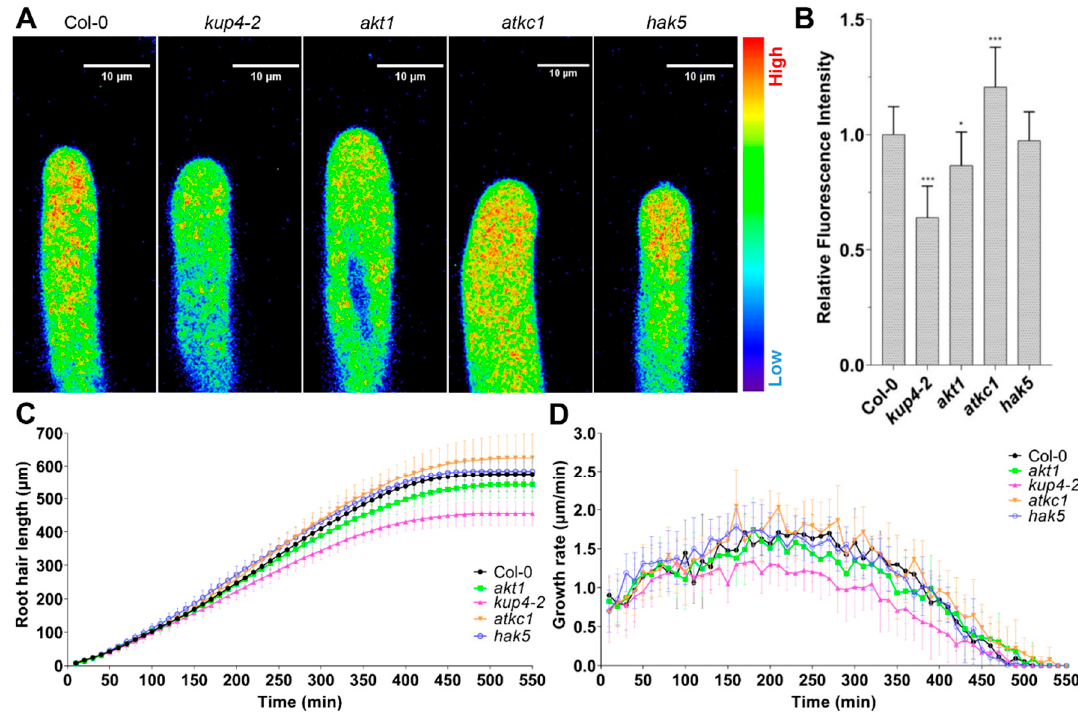
Figure 2. Mutants of K + transporters/channels show altered NK3 fluorescence intensity and root hair growth: ( A ) NK3 fluorescence intensity images of root hairs of Col-0, kup4-2 , akt1 , atkc1 , and hak5 immersed in ½ MS medium containing 1 μ M NK3 and visualized using pseudocolor; ( B ) Quantification of the fluorescence intensity in A. Bars represent the average intensity (mean ± s.d.) of fourteen hairs (Student’s t -test between Col-0 and mutant seedlings; * p < 0.05, *** p < 0.001); ( C ) Growth curve of root hairs of 5-day-old green seedling of Col-0, kup4-2 , akt1 , atkc1 , and hak5 transferred on ½ MS medium. Bars represent the average length (mean ± s.d.) of twelve hairs; ( D ) Growth rate curve of root hairs in C.